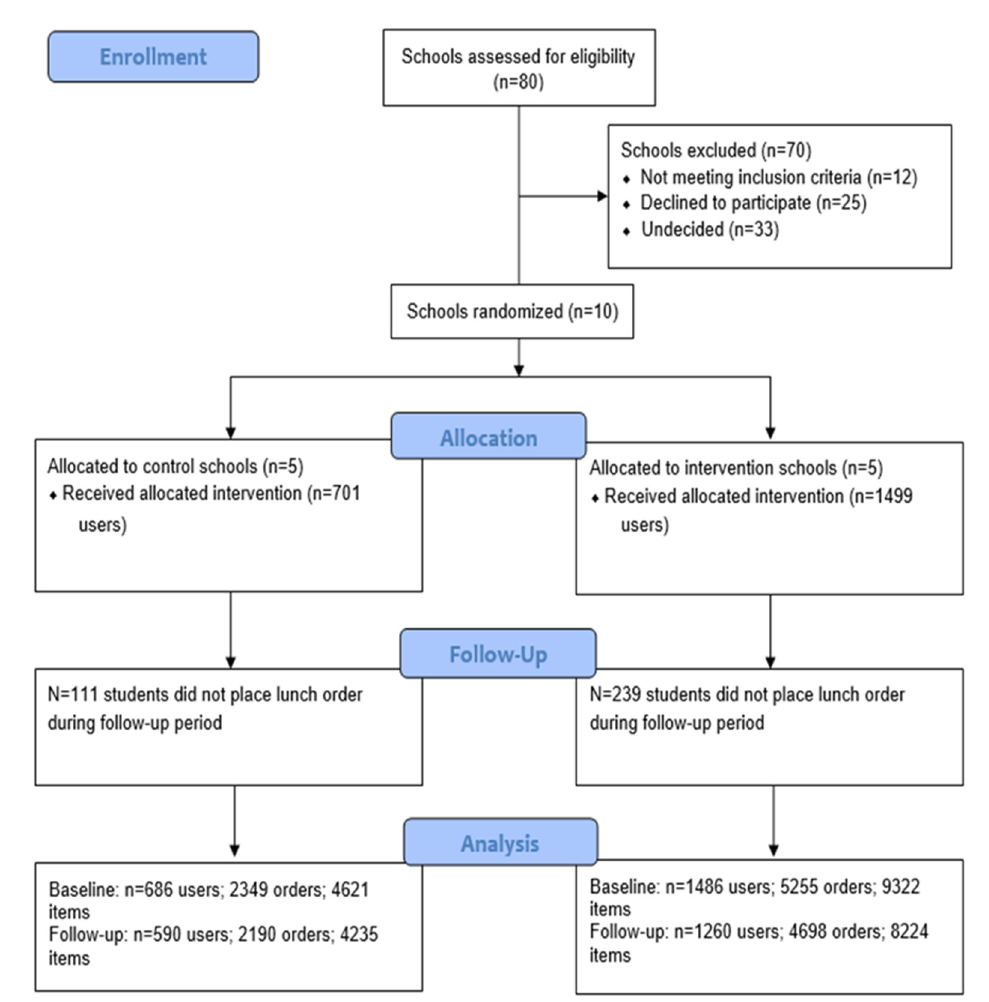
Figure 2. Participant Flow (CONSORT).